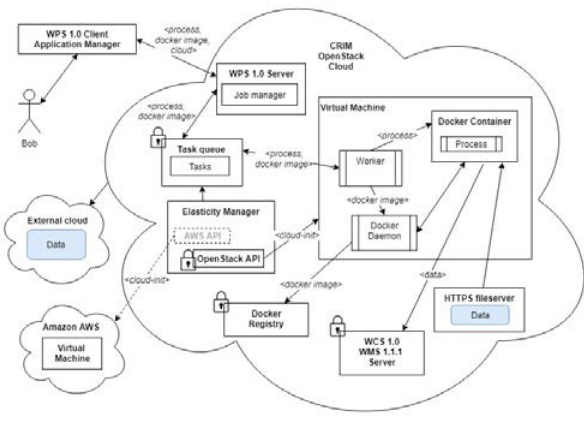
Figure 3. Cloud architecture contributed by CRIM in OGC Testbed-13 Cloud